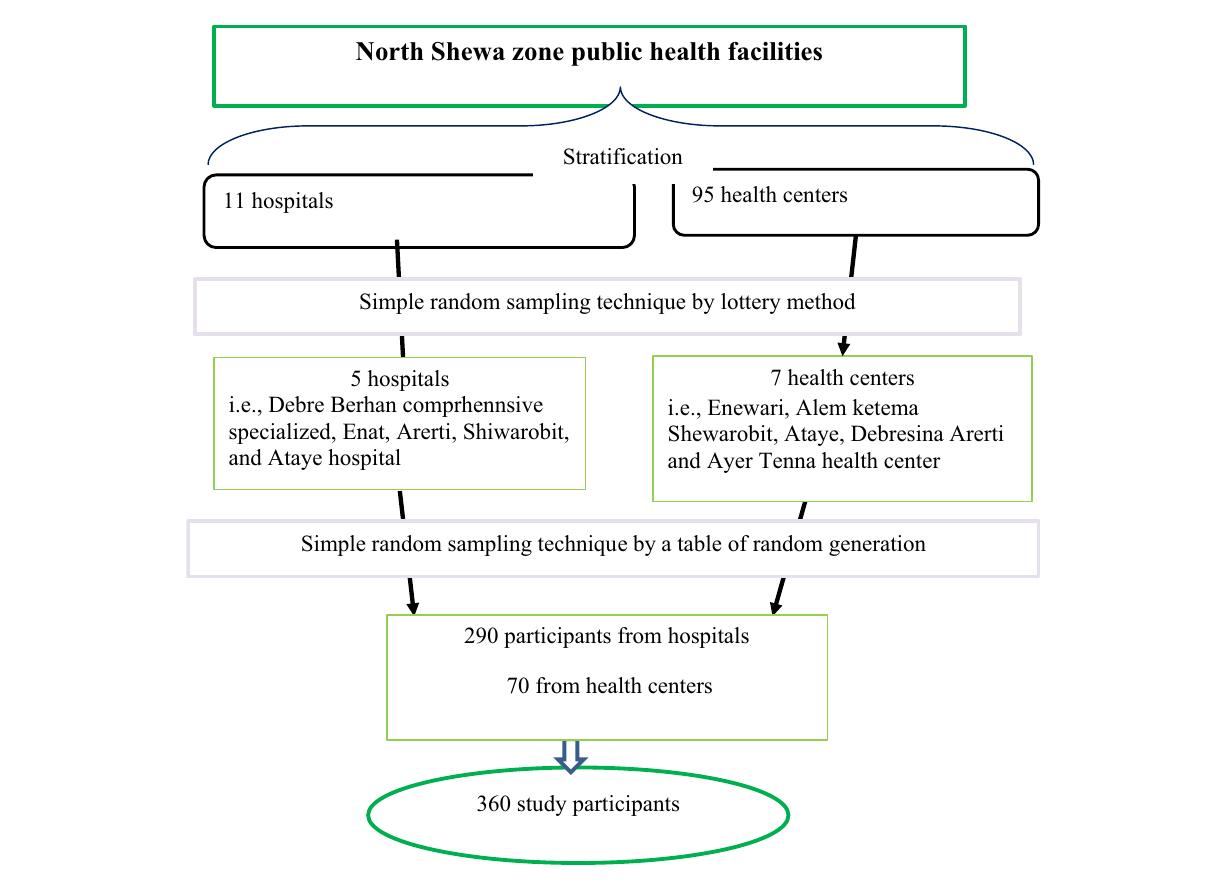
FIGURE 1 Utilization of non-pneumatic anti-shock garment for the management of obstetric hemorrhage among healthcare providers in north Shewa zone,